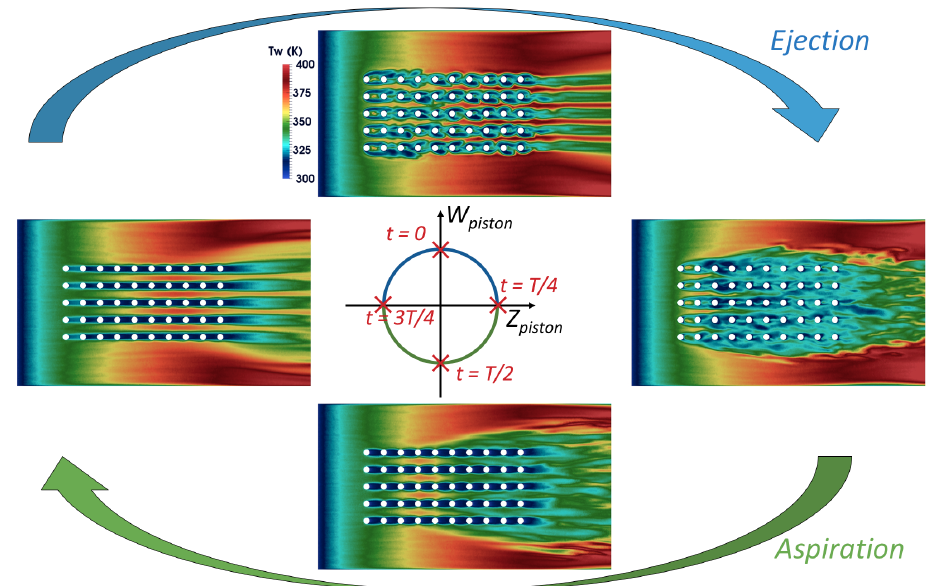
Figure 7. Instantaneous plate temperature field along the perforated plate at different times dis- tributed along a period T obtained with Φ = 1500 W.m − 2